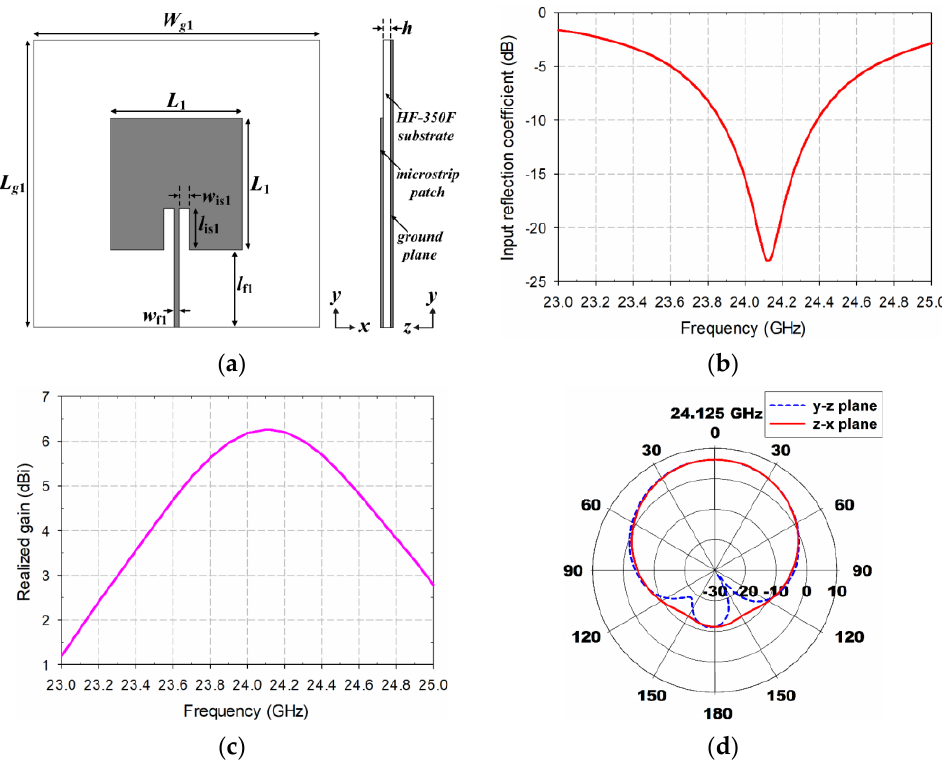
Figure 1. Design and performance of the single microstrip patch antenna: ( a ) the geometry, ( b ) the input reflection coefficient, ( c ) realized gain in the + z -axis direction, and ( d ) radiation patterns on the y–z and z–x planes at 24.125 GHz.